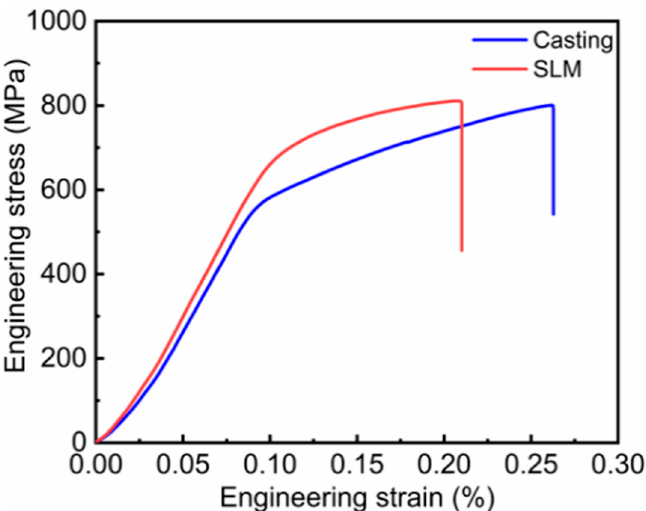
Figure 5. Engineering stress–strain tensile curve for the as-cast and SLM samples.